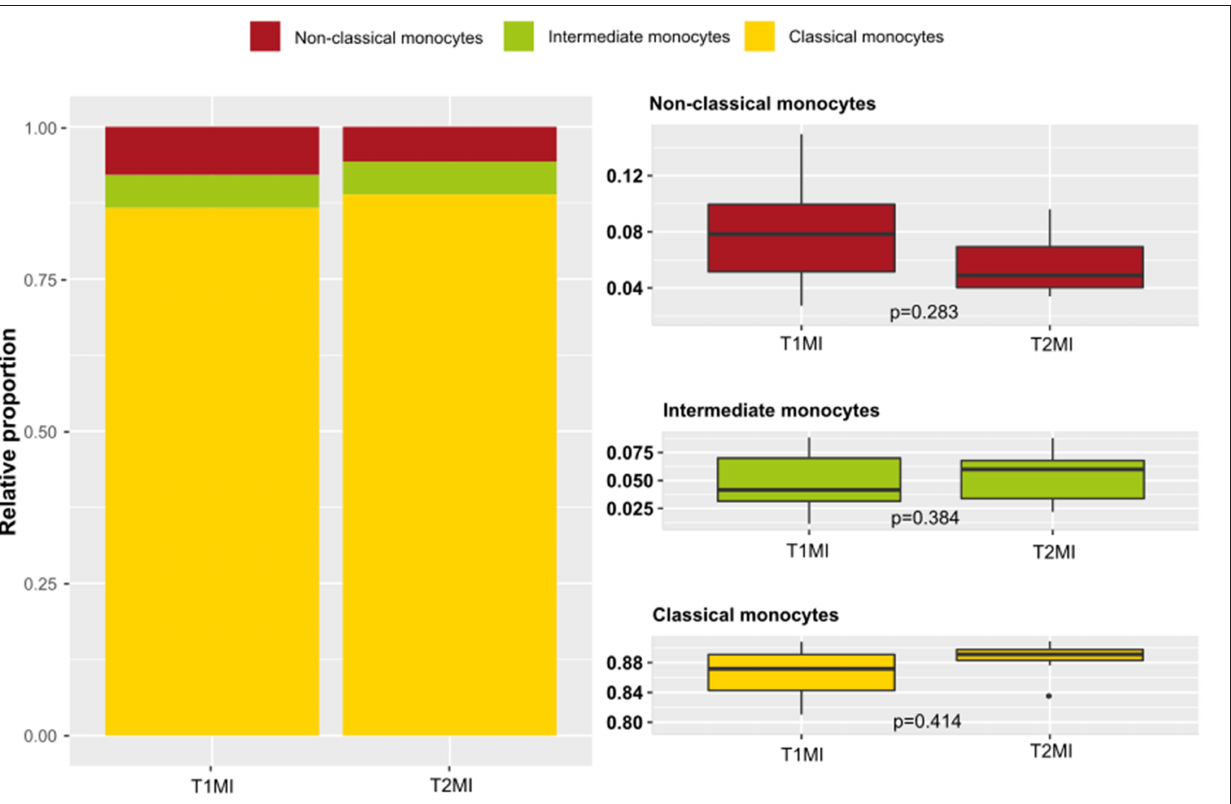
FIGURE 1 | Monocyte subsets in myocardial infarction (MI) type 1 vs. type 2. Presented are data from the ACS cohort ( n = 101) including patients suffering MI type 1 ( n = 52) and type 2 ( n = 10). Left: proportions of monocyte subsets in peripheral blood of patients with an MI type 1 or type 2. Right: box-and-whiskers plot of the distribution of the specific monocyte subsets in type 1 and type 2 MI (whiskers represent the interquartile